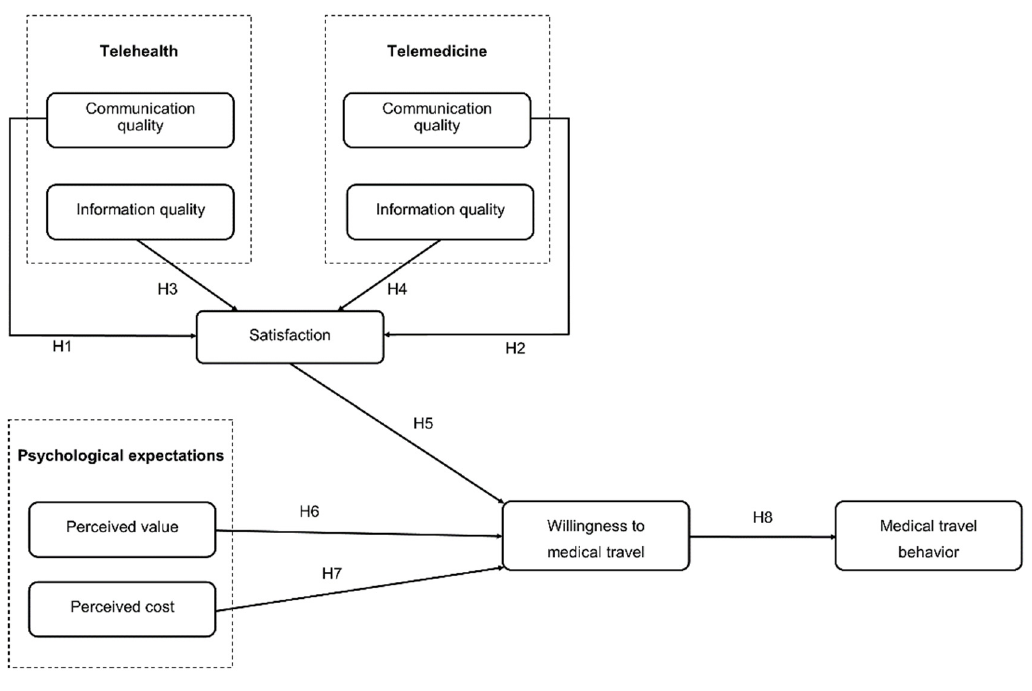
Figure 1. Research model.